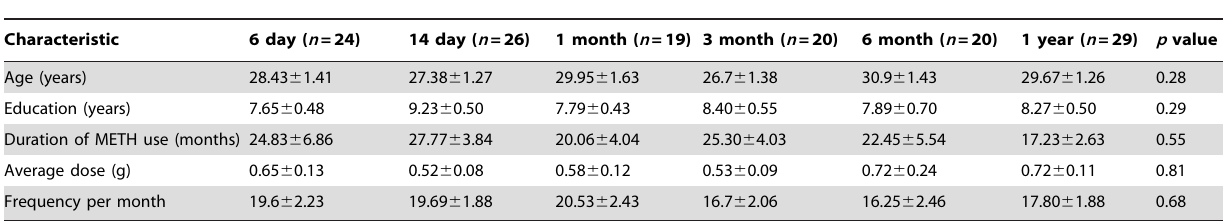
Table 2. Demographic characteristics of METH-dependent